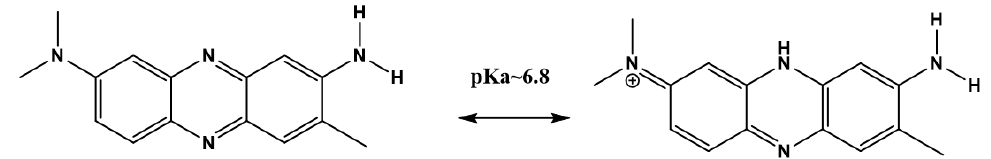
Figure 1. The chemical structure of NR in basic and acidic media, respectively.